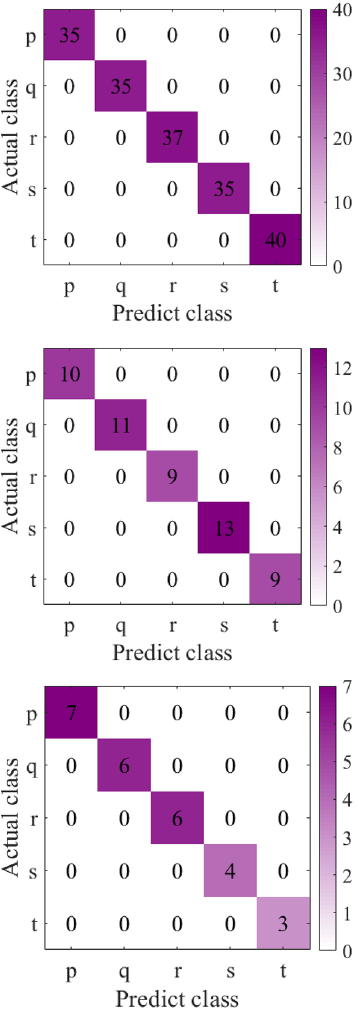
Figure 7. Bearing fault confusion matrix of Xi’an Jiaotong University.